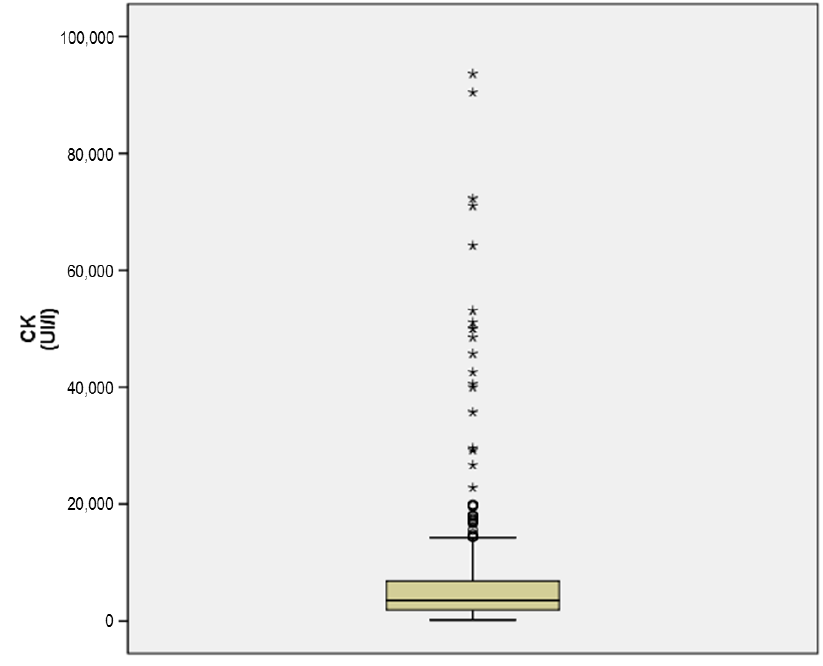
Figure 1. Graphic representation of the glycemia (mmol/L) of bulls after physical exercise.